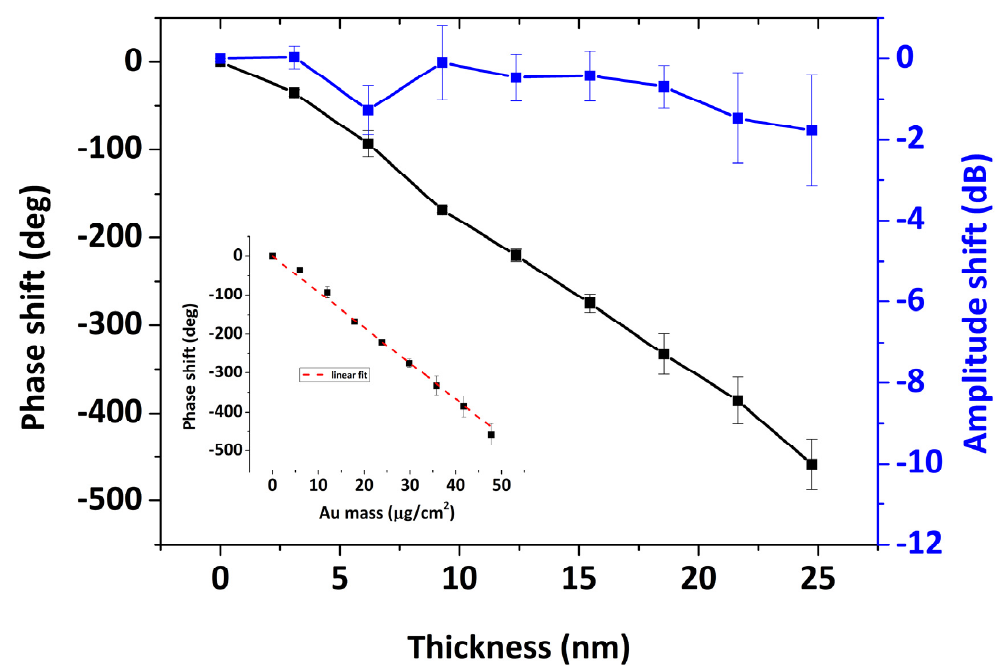
Figure 6. Phase and amplitude shift upon Au deposition up to 24 nm on the sensor surface. ( inset ) Average phase shift as a function of Au mass per unit area (dashed line, linear fit, resulting in slope 9.17 deg cm 2 /g).